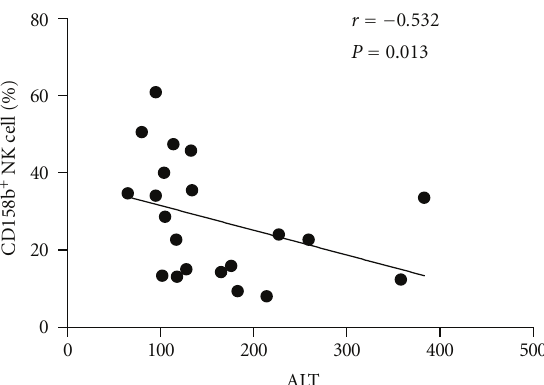
Figure 4: Liver injury was negatively correlated with inhibitory receptor CD158b expression on NK cells. The potential correlation of the percentages of NK cells with the levels of serum ALT in CHB patients was analyzed.